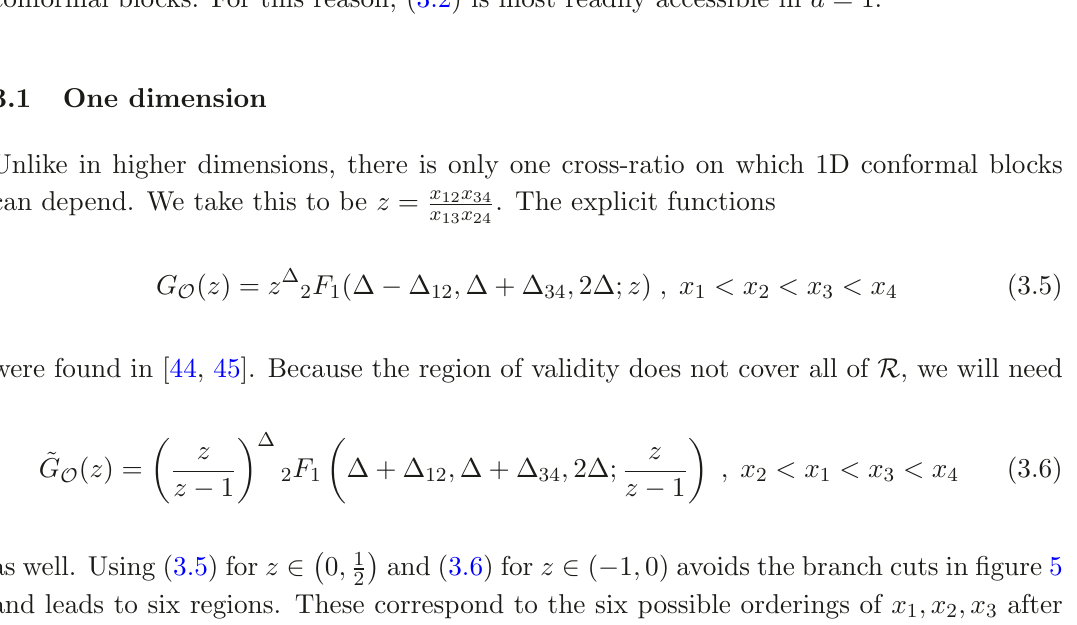
Figure 5. Continuing to complex z , our blocks have one branch cut from from 1 to . This differs from higher-dimensional blocks which are analytic on C ∞ example, we may multiply two SL(2; R ) blocks to get an SL(2; C ) block. This causes the left cut to cancel and the right cut to